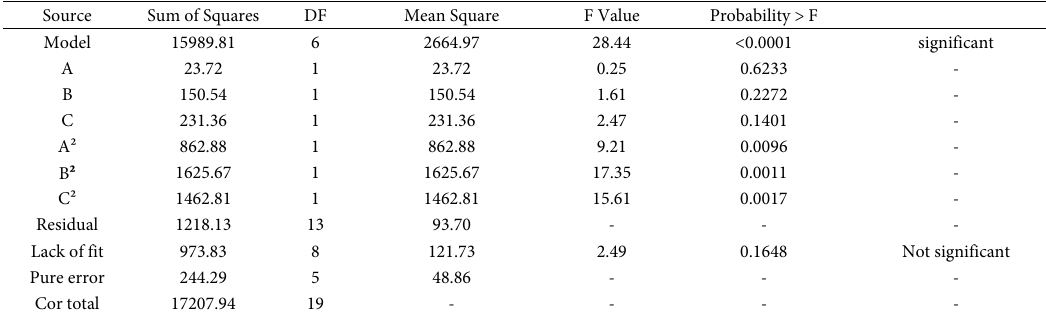
Table 4. Analysis of variance (ANOVA)